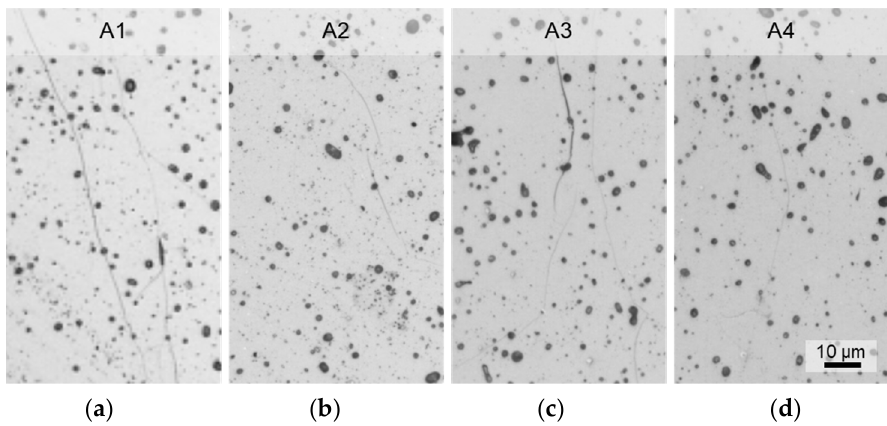
Figure A2. Comparison of fitted temperature-time profiles during the four thermal shock treatments ( a ) graphically, ( b ) by characteristic temperatures after 1- and 10-min cooling. Exemplary optical microscope images of the polished cross-sections of Series from A1 to A4 are given in Figure A3.